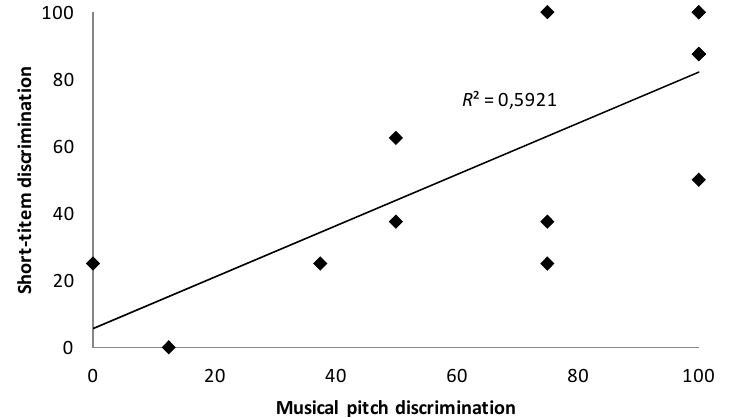
Figure 1. Relationships between musical pitch discrimination and performance on the short-item discrimination task in the WS group.